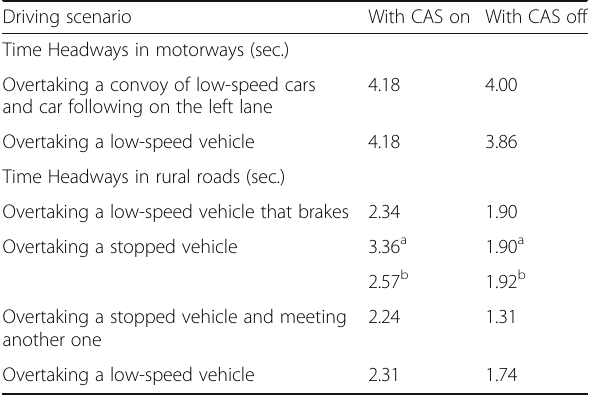
Table 1 Time Headways of drivers on a simulator with/without the CAS activated, in different overtaking scenarios [6] Driving scenario With CAS on With CAS off Time Headways in motorways